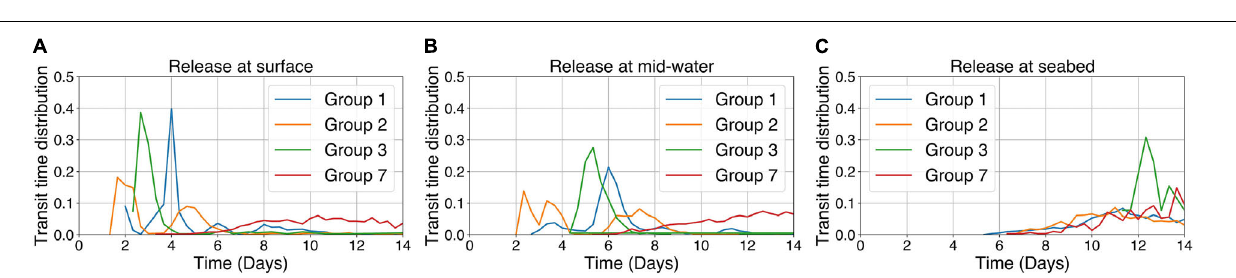
indicating that loss of larvae to the system through entrainment into the Gulf Stream is likely to be greater than indicated from the models run with long-term averaged currents. None of the scenarios show connectivity from any of the release sites